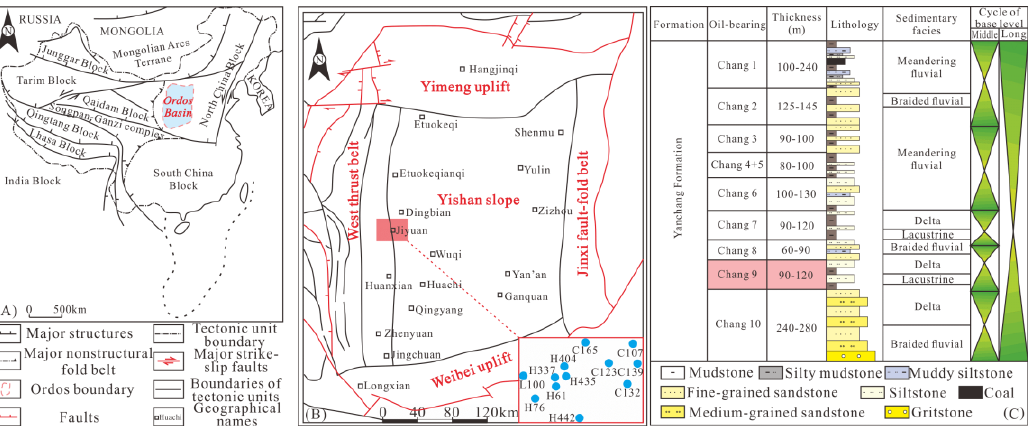
Figure 1. ( A ) Basin location; ( B ) Ordos Basin structural unit division; ( C ) Yanchang Formation stratigraphic framework.